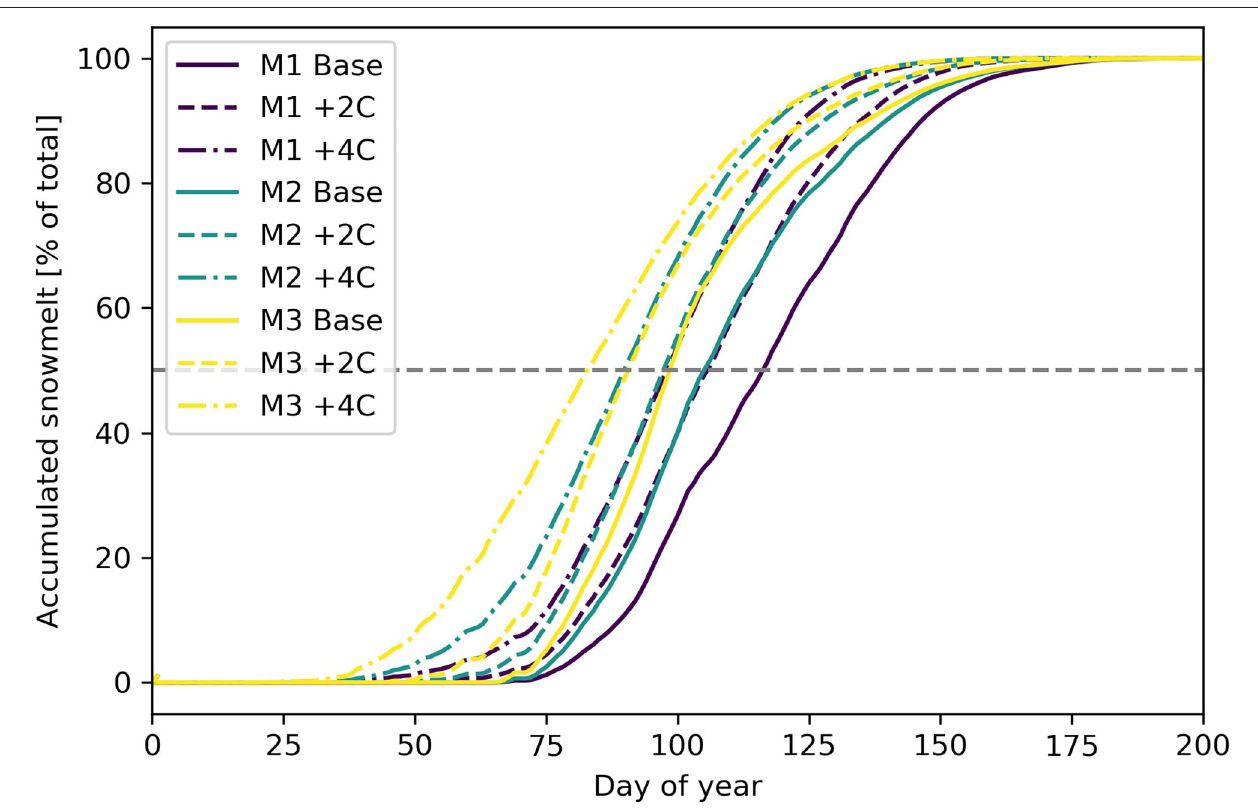
FIGURE 8 | Accumulated snowmelt for temperature increases of + 2 ◦ and + 4 ◦ C, calculated for three hypsometry classes. The center of snowmelt mass corresponds to the intersection of the gray horizontal line and the accumulated snowmelt curves. proportional areas at higher elevations (M1) see the smallest changes for the duration of the melt